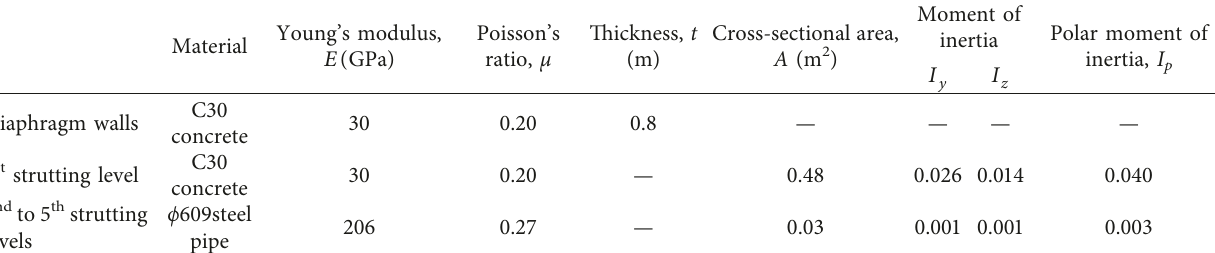
Figure 3: Support structure model. Table 2: Parameters of the support structure.